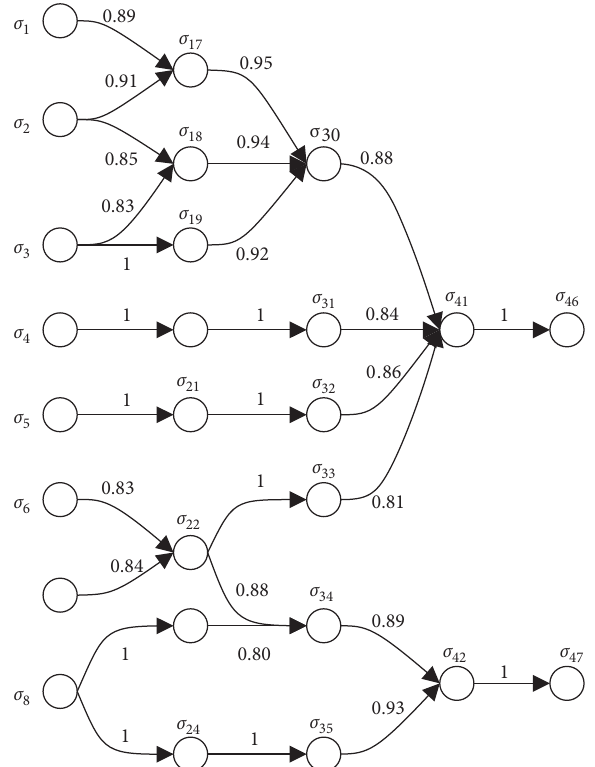
Figure 7: The tightness degree among PNs.